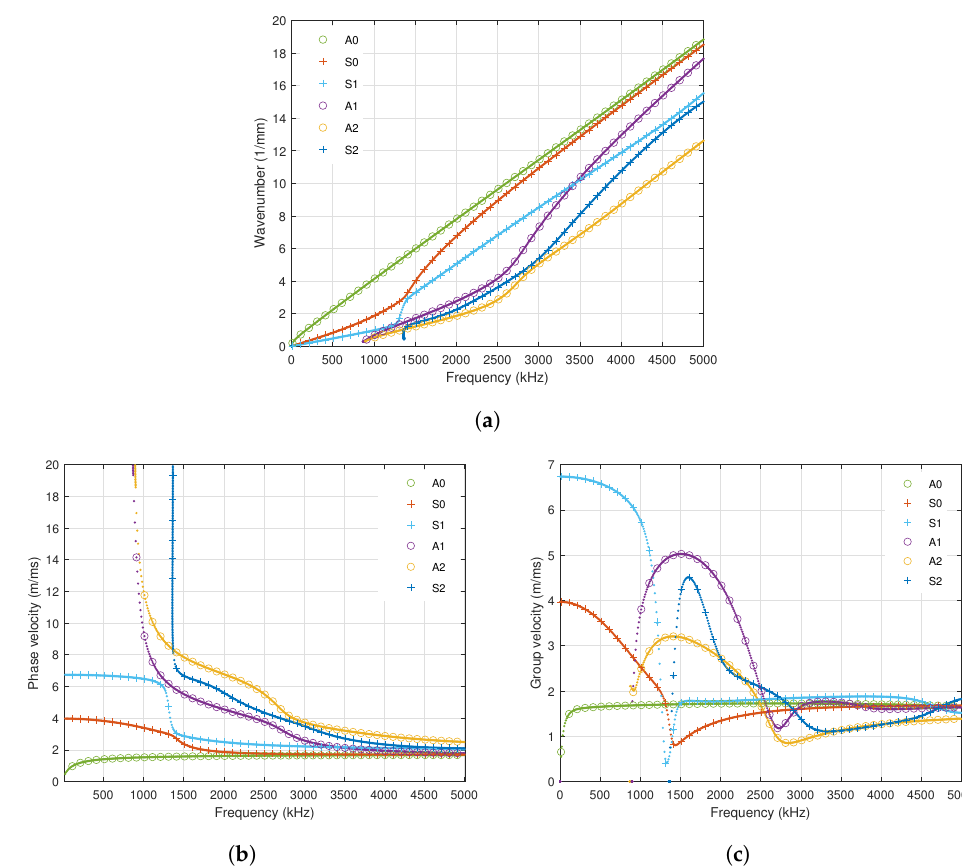
Figure 8. Dispersion curves of the first six modes of propagating waves in a 1mm thick composite plate; .... Dispersion Calculator, + SAFE method (symmetric modes), o SAFE method (anti-symmetric modes); ( a ) wavenumber, ( b ) phase velocity, ( c ) group velocity vs.